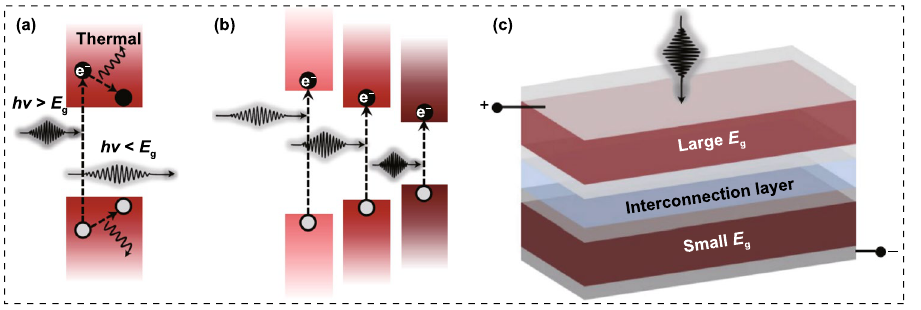
Fig. 1 Schematic illustration of light absorption in a single and b multi-junction solar cells. c Two-terminal tandem devices. Reproduced with permission from Ref. [22]. Copyright 2021, Nature Publishing